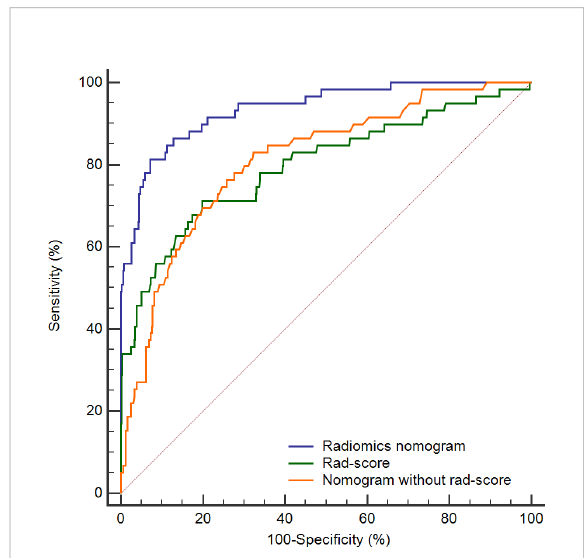
FIGURE 6 ROC curves for rad-score (green line), radiomics nomogram (blue line), and nomogram without rad-score (orange line). The AUC of radiomics nomogram is signi fi cantly higher than the remaining two curves (both P < 0.05). ROC, receiver operating characteristic; Rad-score, radiomics score; AUC, area under the